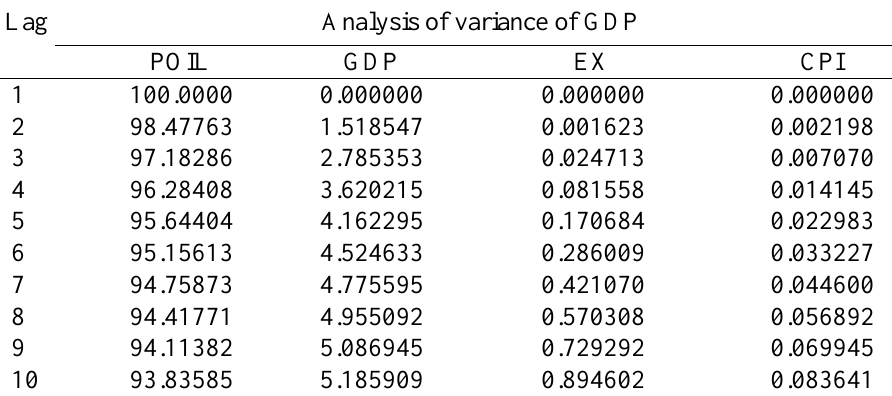
Table 7. Analysis of variance for oil price